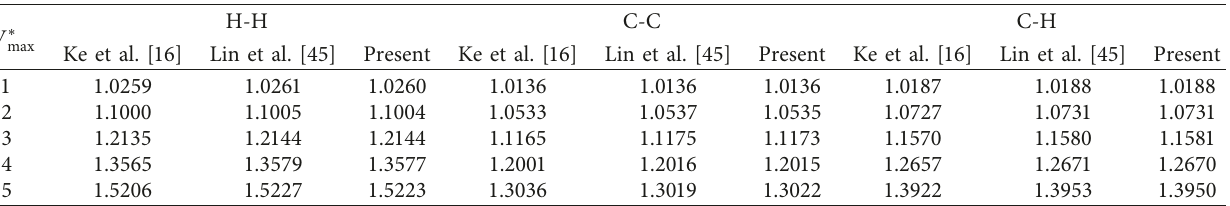
Table 4: Comparison of nonlinear to linear frequency ratios ω